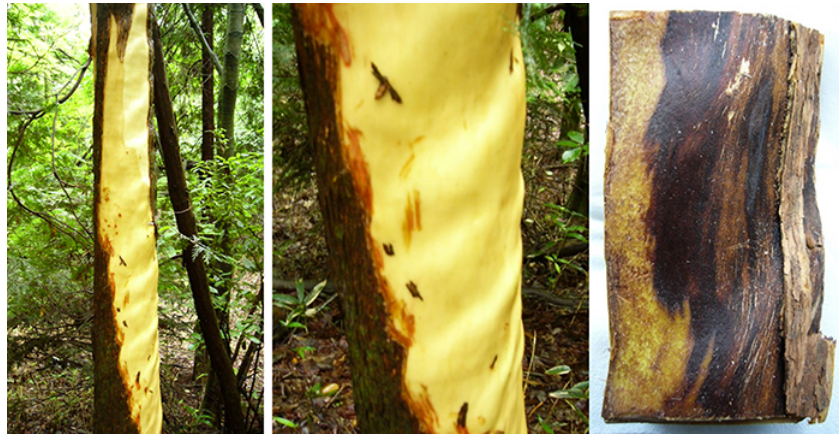
Figure 9 Clethra barbinervis tree with Z-oriented numerous ripples, from which the wood sample for anatomical analysis was isolated by a shallow tangential cut in the year 2003; the surface (right) of this isolate shows a superposition of radial and transverse waviness in Z/S